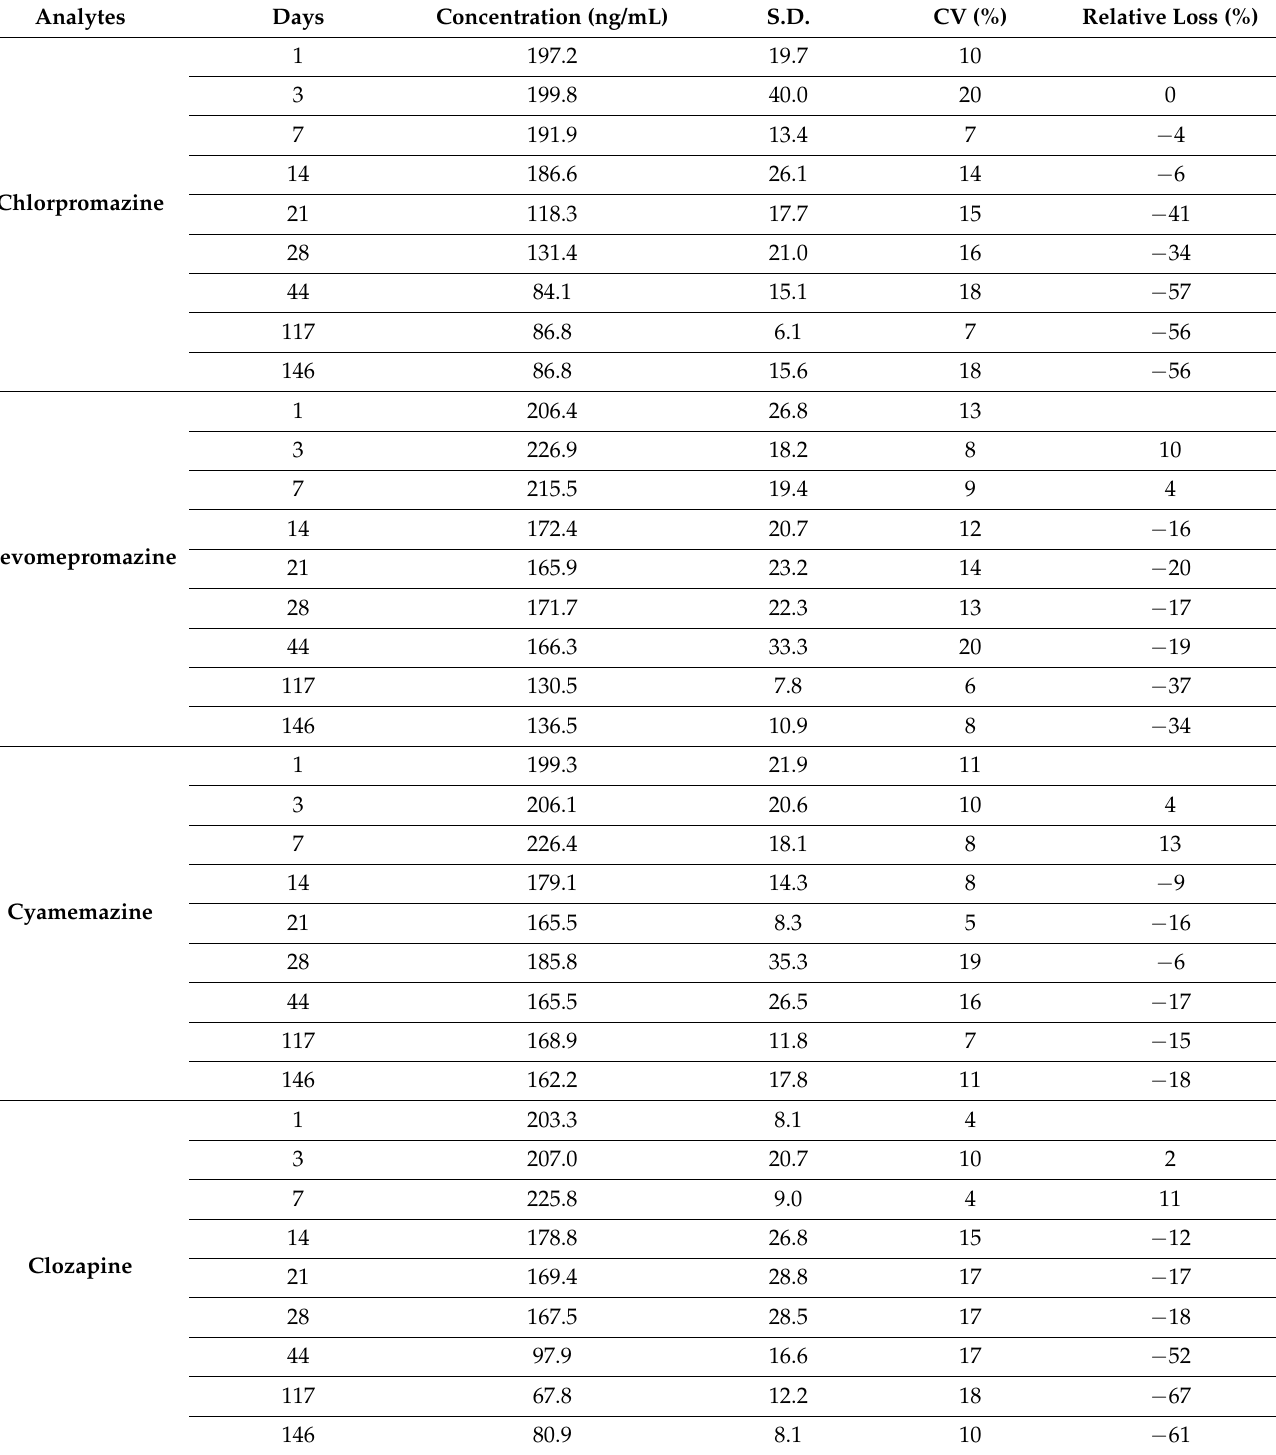
Table 3. Results of stability of antipsychotic drugs chlorpromazine, levomepromazine, cyamemazine, clozapine, haloperidol, and quetiapine over 146 days (n =